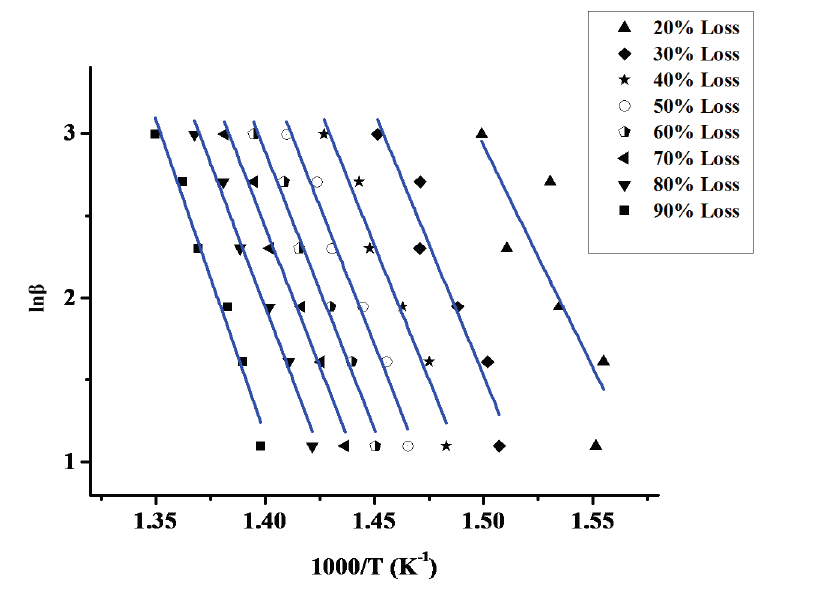
Figure 3. Ozawa-Flynn-Wall plots ln β vs. 1/T for the sample 20/80 at different heating